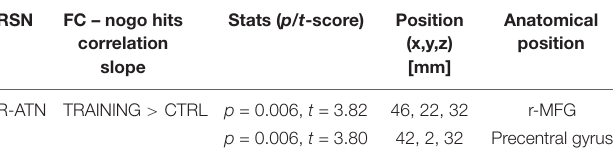
TABLE 3 | Summary of score-within-network (SWN) within R-ATN: group × nogo hits significant